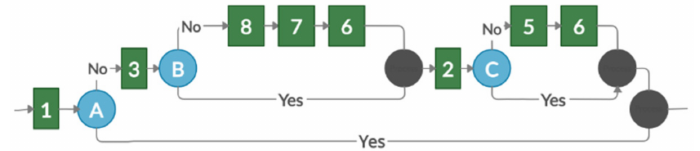
Figure 1. Presentation of tasks by the contextual